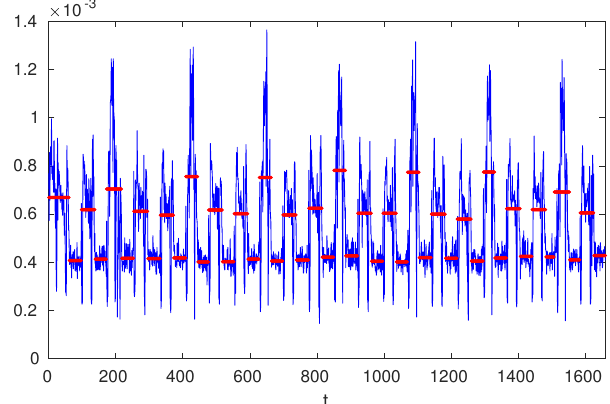
Figure 4. Change points and mean of each segment based on r M